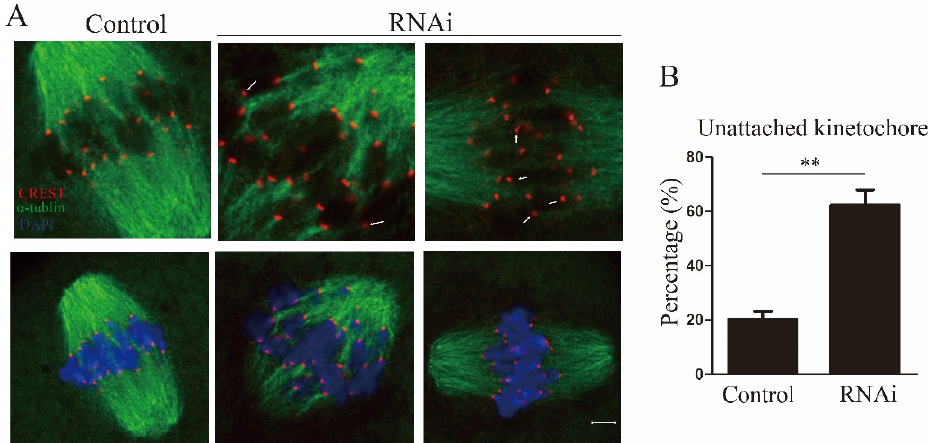
Figure 4. Rae1 knockdown weakens kinetochore–microtubule (K-MT) attachment in oocytes. ( A ) Representative confocal image of K-MT attachment in the control and Rae1 knockdown MI oocytes after cold treatment. α -tubulin is shown in green, CREST in red, and DAPI in blue. White arrows indicate nonconnected kinetochores in the Rae1 knockdown oocytes. Scale bar = 5 μm. ( B ) The rate of unattached kinetochores was recorded and compared in the control ( n = 125) and Rae1 knockdown oocytes ( n = 143). ** p < 0.01. The data are presented as mean ± SEM of at least three independent experiments.